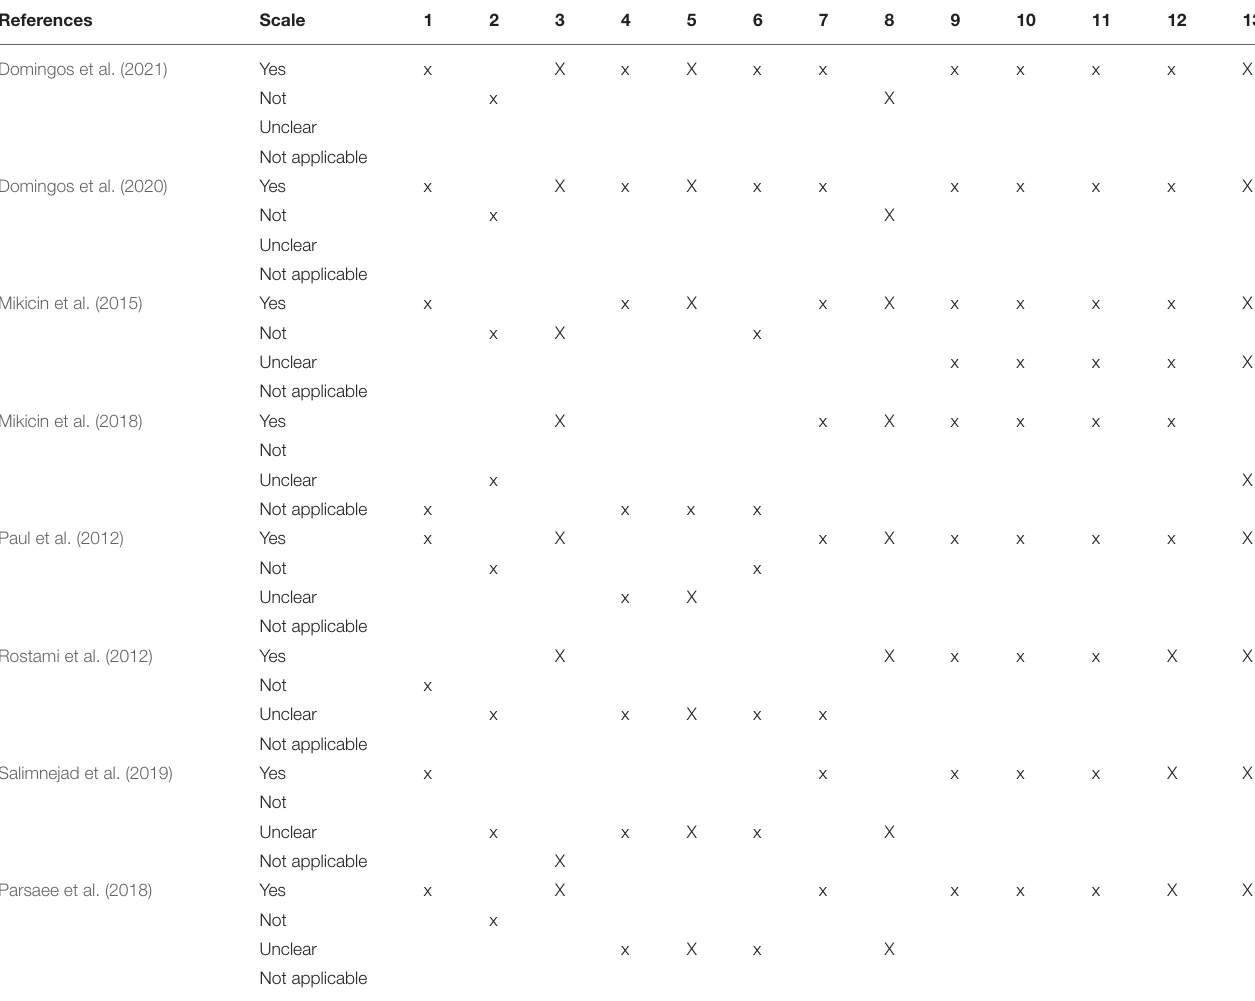
TABLE 2 | Critical appraisal assessment checklist for randomized controlled